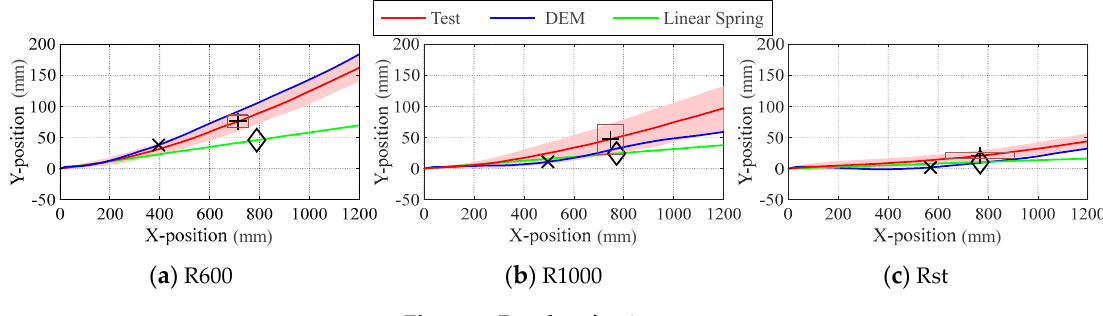
Figure 9. Results of